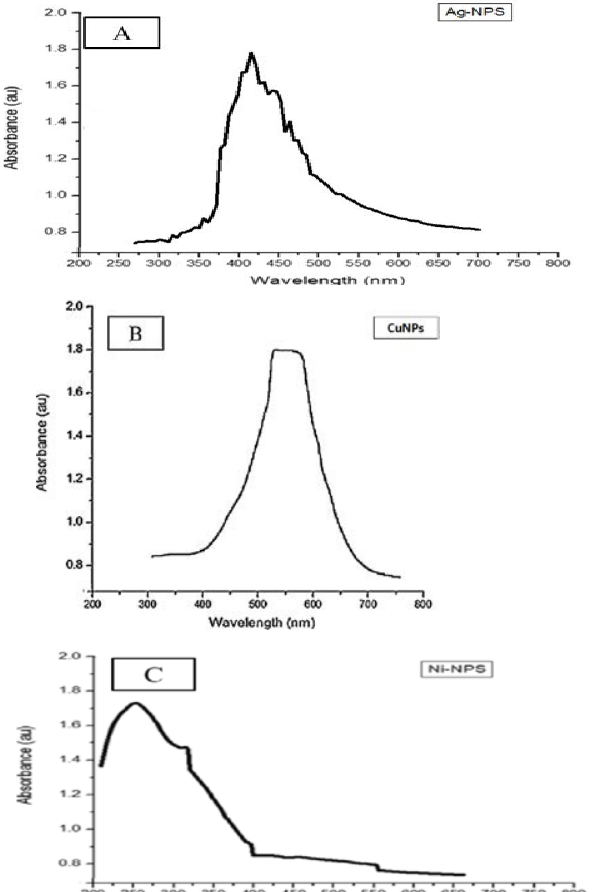
Fig. 1. UV-visible analysis for Ag-NPS (A), CU-NPS (B), Ni-NPS (C), synthesized by